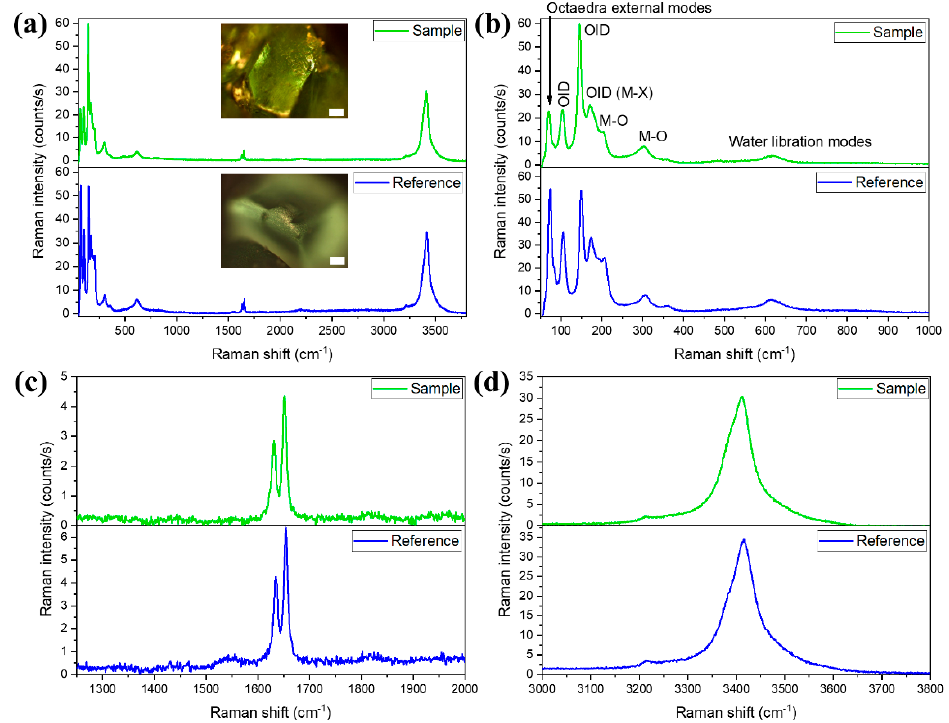
Figure 7. Micro-Raman spectra recorded on the CFC sample (blue) and the FFC sample (green). The excitation wavelength is 633 nm. ( a ) Spectra showing all of the Raman peaks obtained. In the inset, optical images of both reference and obtained crystals are shown. ( b ) Raman modes appearing in the low-frequency range (50–1000 cm − 1 ). ( c ) Intermediate frequency range (1250–2000 cm − 1 ). ( d ) High-frequency range (3000–3800 cm − 1 ). In all cases, the scale bar is 100 µm.